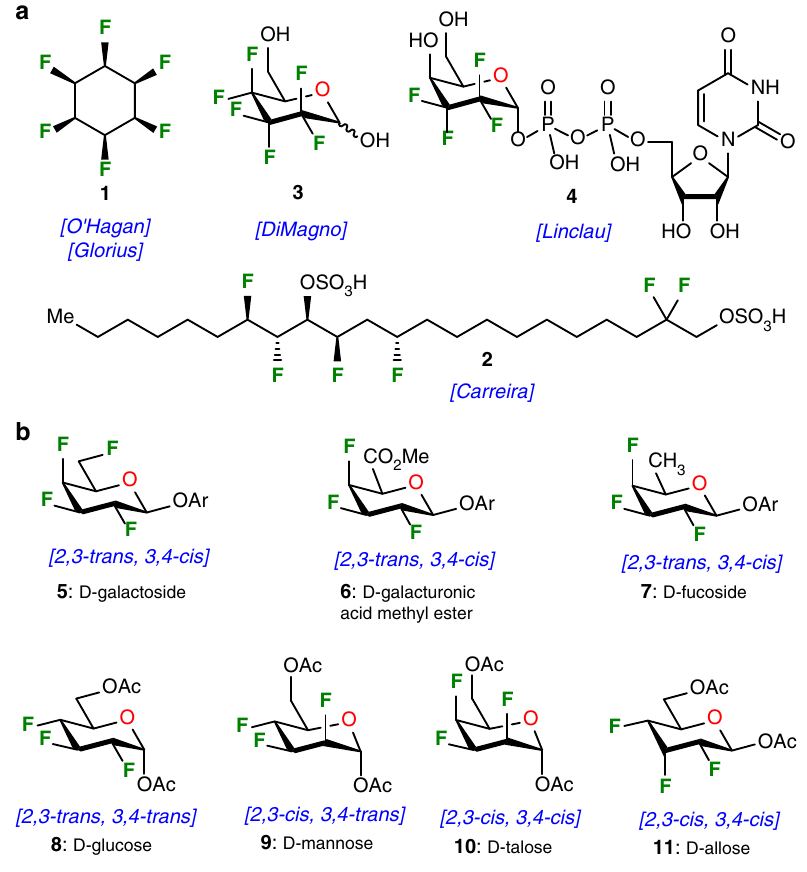
Fig. 1 Heavily fl uorinated organic molecules. a all- cis -1,2,3,4,5,6-hexa fl uorocyclohexane 1 , fl uorodanicalipin A 2 ; hexa fl uorinated carbohydrate analogs 3 , and tetra fl uorinated UDP-galactopyranose 4 ; b This work: fl uorinated D -galactoside 5 , D -galacturonic acid methyl ester derivative 6 , D -fucoside 7 , D -glucose 8 , D -mannose 9 , D -talose 10 , and D -allose